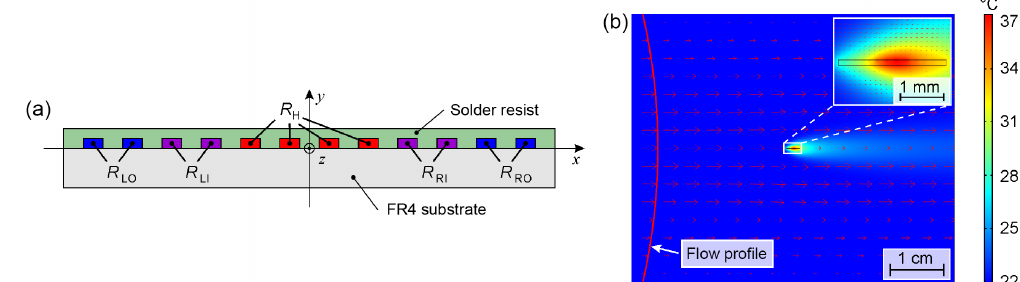
Figure 3. (a) FEM model cross section of the calorimetric flow sensor. Grey is the FR4 substrate, green the solder resist, red the heater leads ( R H ), and blue and purple the sensing leads. The indexes indicate the position on the PCB: L/R means left/right to the hater, and O/I means outer/inner thermistor. (b) Result of the FEM simulation for a constant heating current of I H = 115mA. The red arrow indicates the velocity field at an average flow velocity of v = 0 . 1ms − 1 .